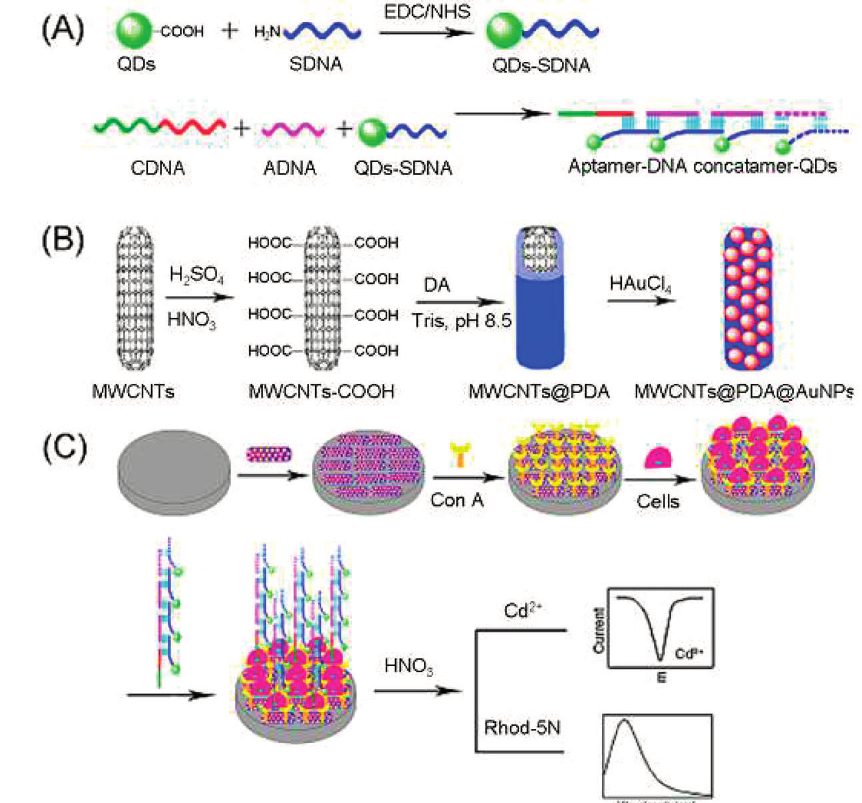
Figure 2. Procedures for the Fabrication of Aptamer-DNA Concatamer-QDs ( A ) MWCNTs@PDA@AuNPs Composites; ( B ) and Supersandwich Cytosensor; ( C )